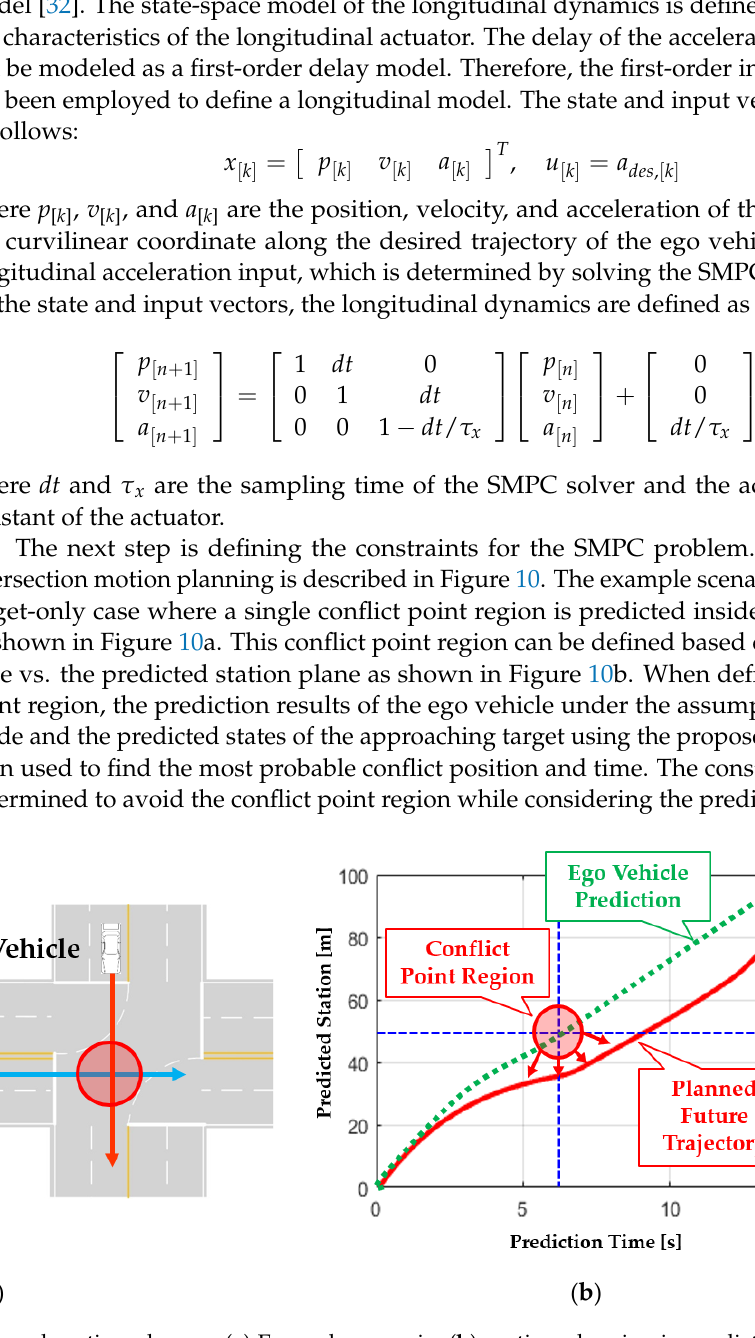
Figure 10. Concept of the proposed motion planner. ( a ) Example scenario; ( b ) motion planning in predicted station vs. prediction time plane.